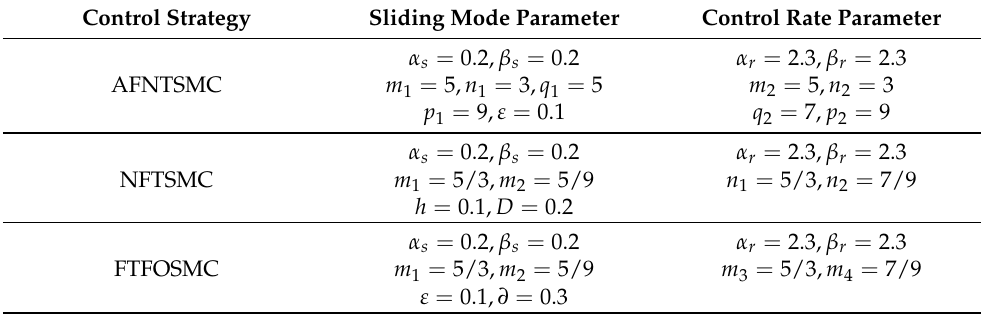
Table 3. The control parameters of AFNTSMC and FTFOSMC.